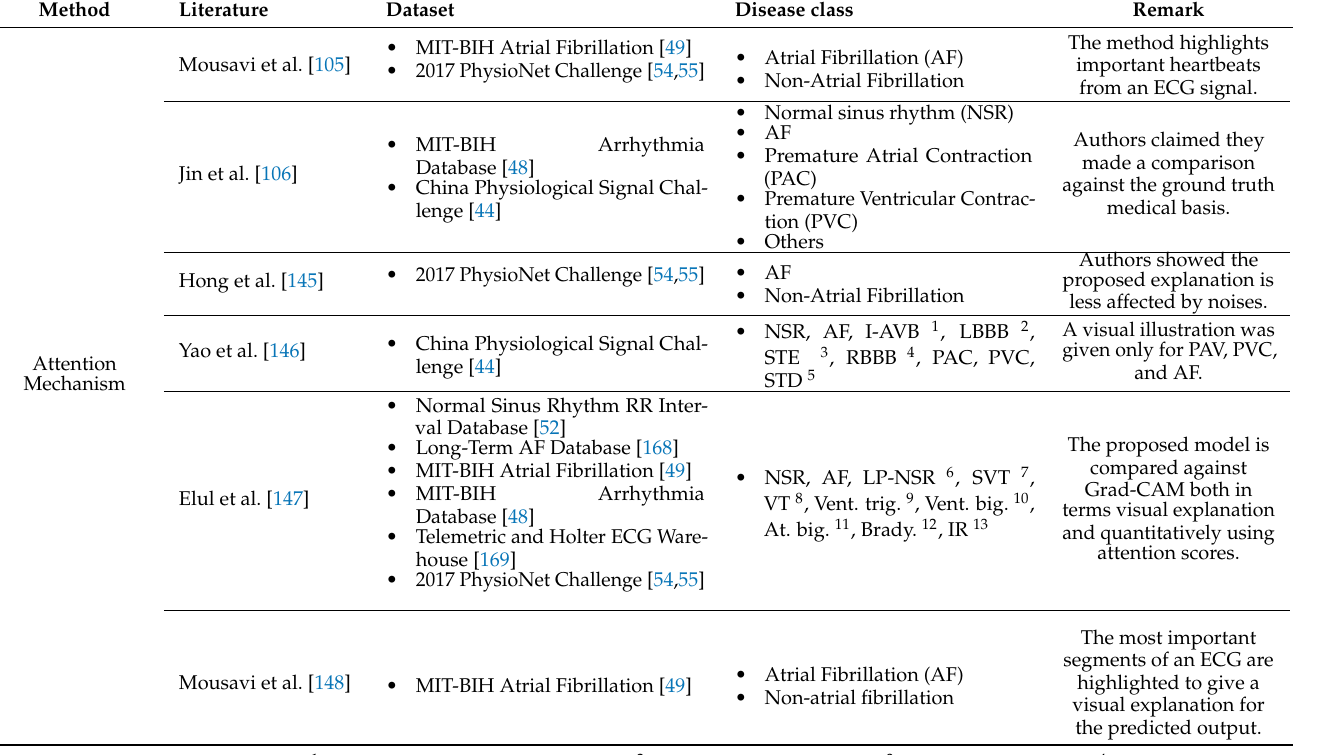
Table 7. Attention mechanism-based–visual observation-based IML technique performance